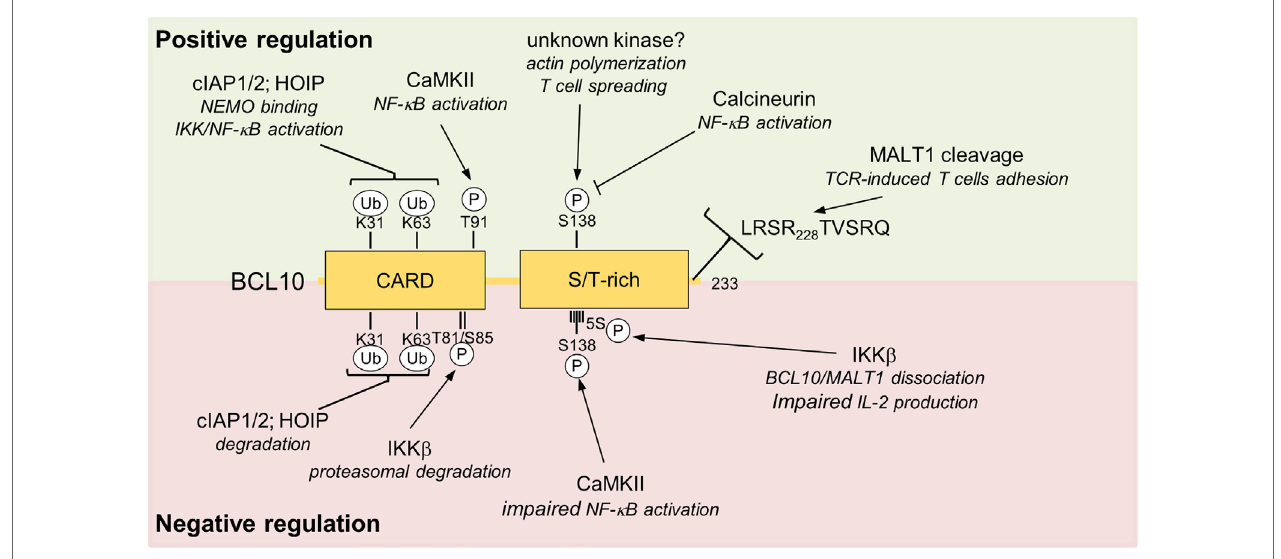
FiguRe 4 | Positive and negative regulations of BCL10. Positive and negative regulating post-translational modification sites (phosphorylation and ubiquitination) and MALT1 cleavage site are depicted. Upper box highlighted in green shows modifications of BCL10 associate with positive impact on T cell activation. The red lower box summarizes negative regulatory effects that impinge on BCL10. Abbreviations: CARD, caspase-recruitment domain; S/T-rich, serine/threonine-rich region; BCL10, B-cell lymphoma/leukemia 10; MALT, mucosa-associated lymphoid